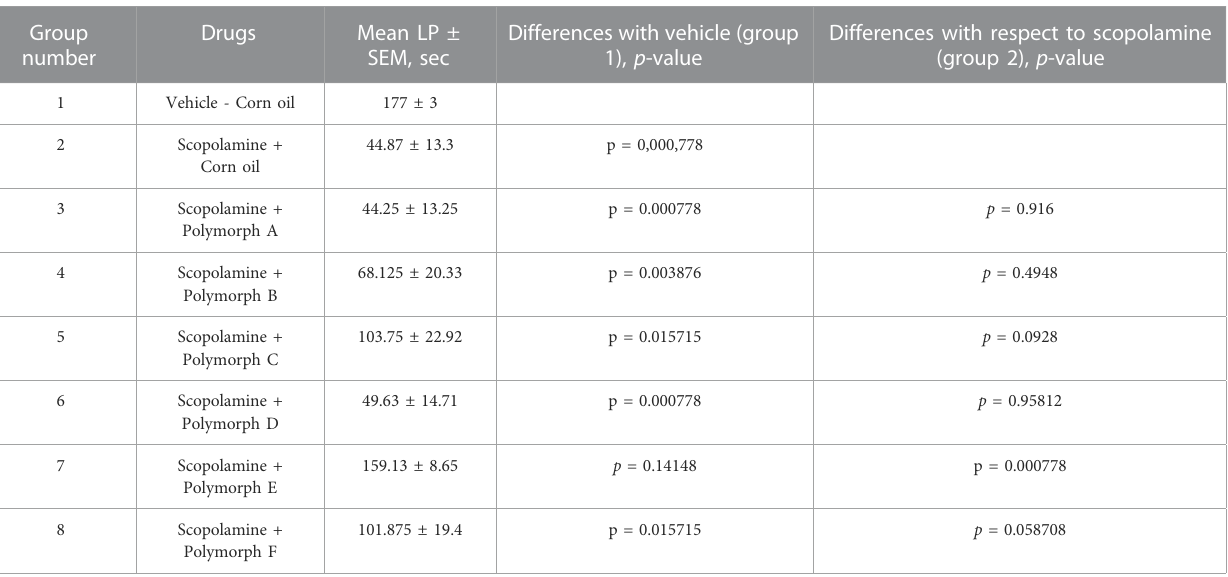
Differences with vehicle (group Differences with respect to scopolamine 1), p -value (group 2), p -value